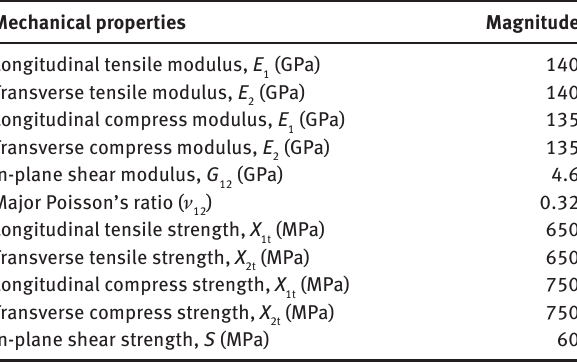
Table 1: Material parameters of woven fabric/epoxy specimens calculated from experimental